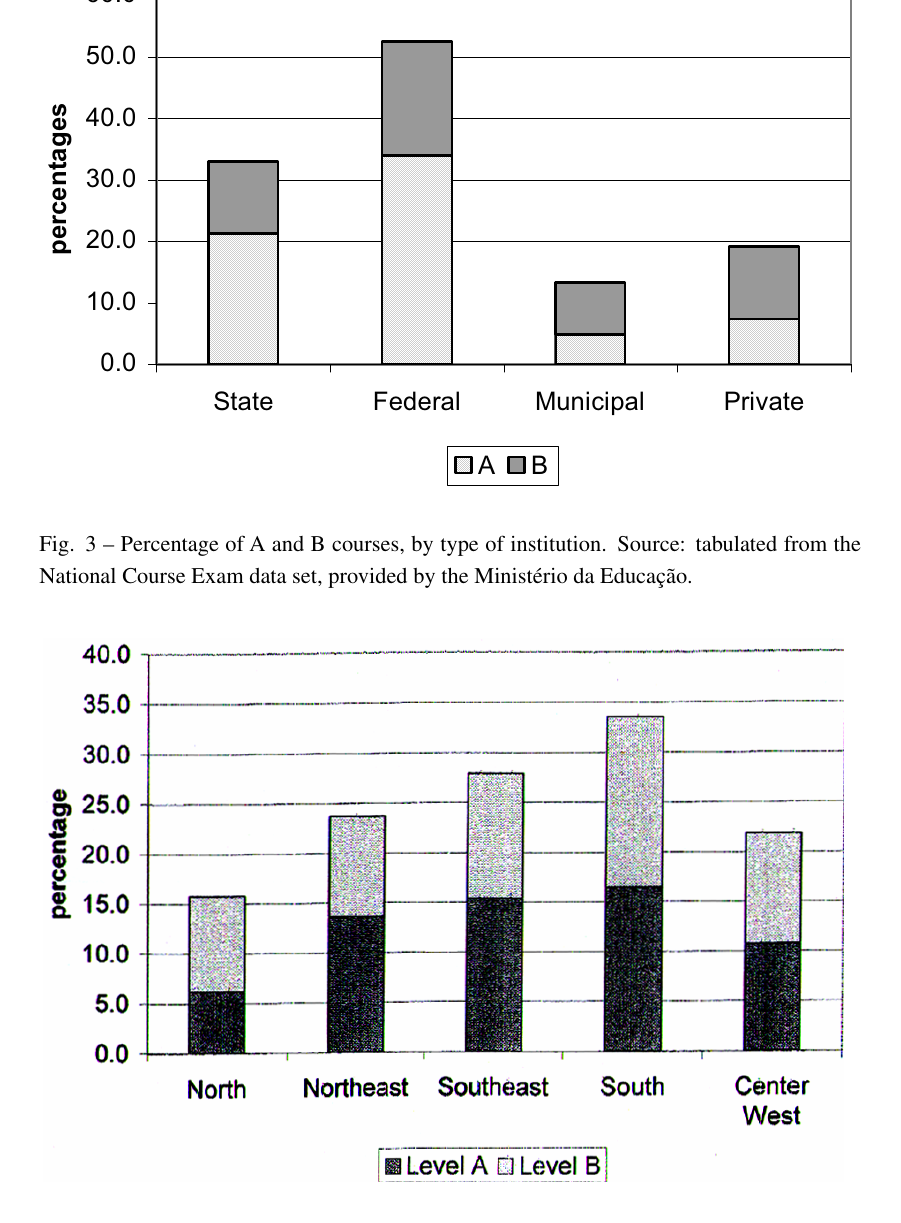
Fig. 4 – Percentage of A and B courses, by region. Source: tabulated from the National Course Exam data set, provided by the Ministério da